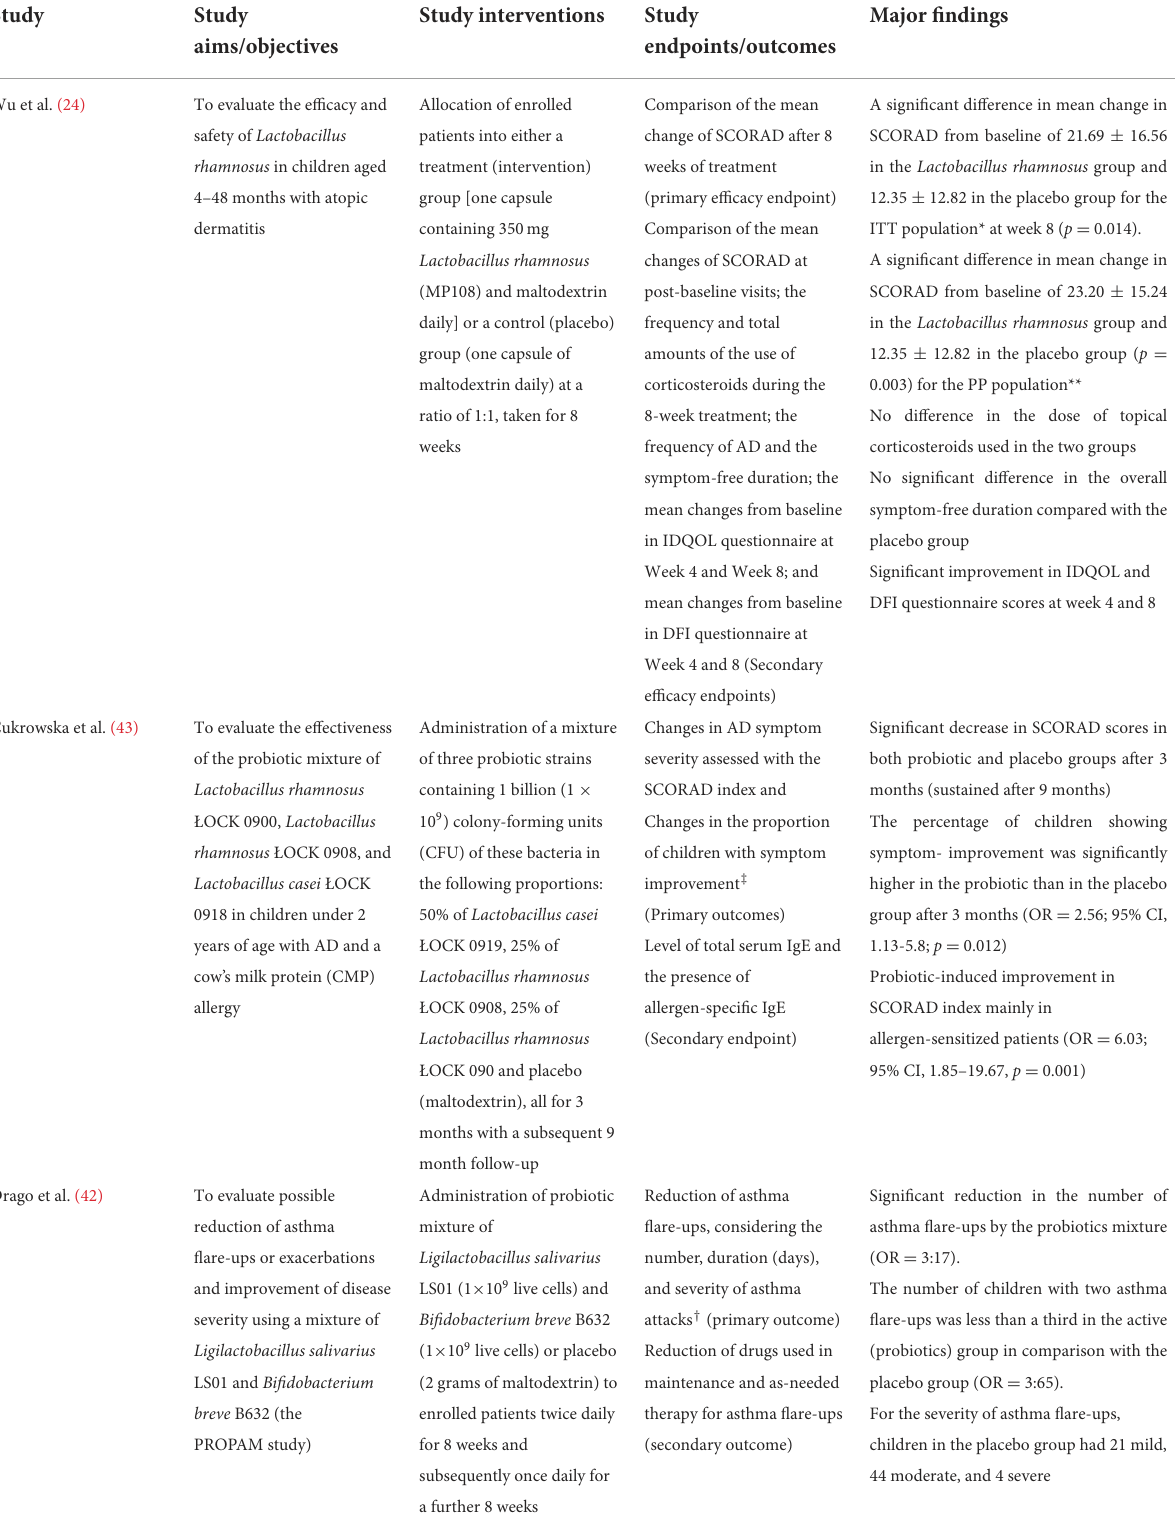
TABLE 2B Major findings of the randomized controlled trials on probiotic administration for the prevention or treatment-optimization of asthma/atopic